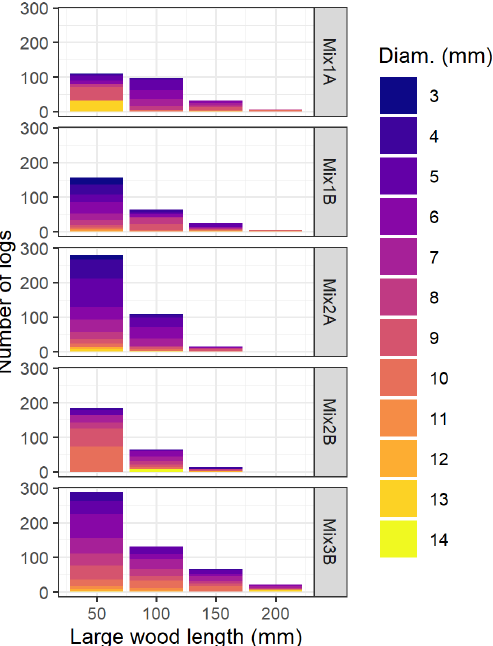
Figure 3. Number, length and diameter of coarse debris comprising the LW